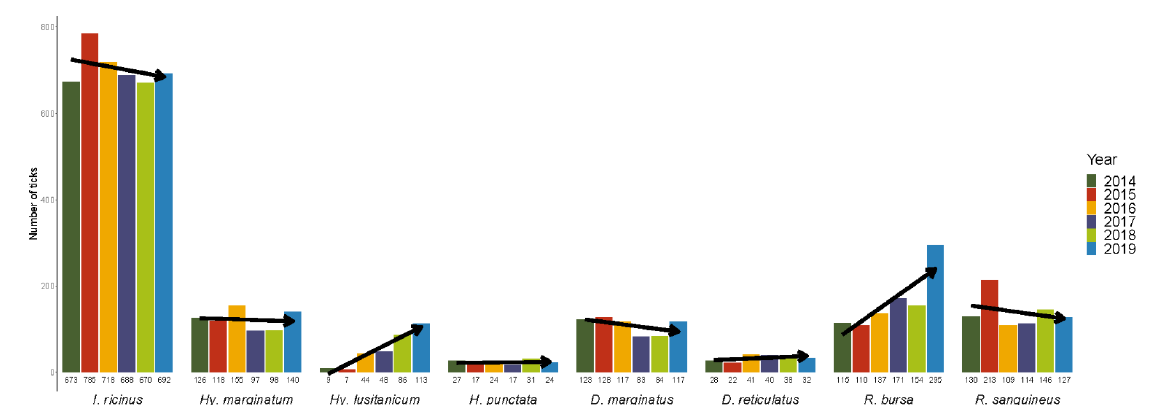
Figure 2. Trends in the number of ticks recovered over time.